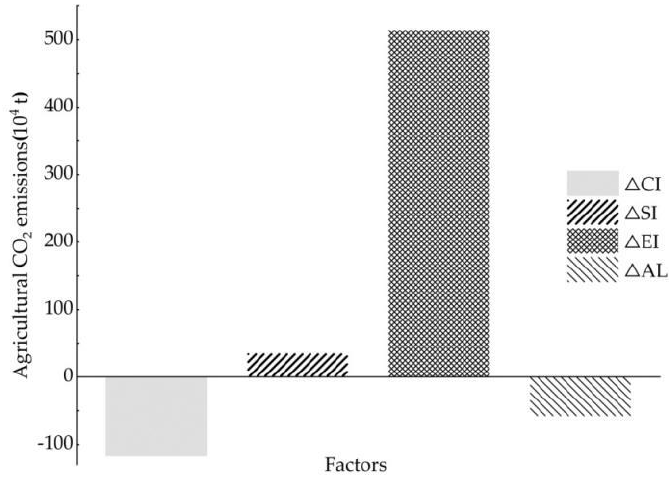
Figure 6. Total contribution of four factors to agricultural CO 2 emissions in Jilin province. Figure 7 depicts the differences in the change characteristics of the four factors.